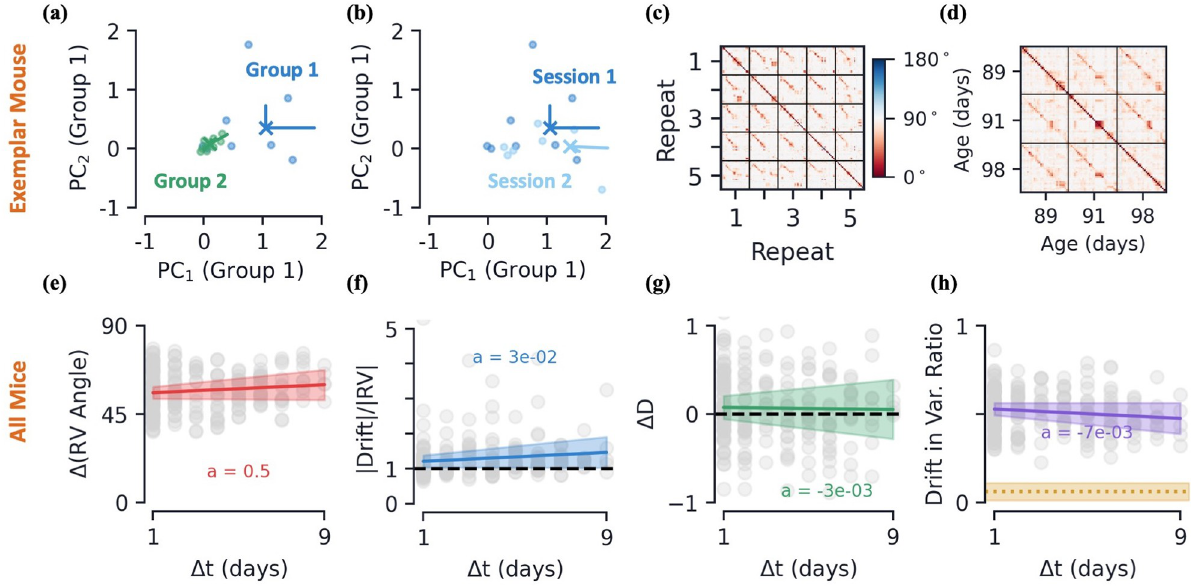
Fig 2. Passive data: Feature space, drift, and drift’s dependence on time. [a-d] Data from an exemplar mouse. (a) Response vectors (dots), mean response vectors (X’s), and first two PC dimensions (lines, scaled by variance explained), for two stimulus groups in a given session. Plotted in stimulus group 1’s PC space. (b) Same as previous subplot, but response vectors of stimulus group 1 across two different sessions, plotted in session 1’s PC space. (c) Pairwise angle between the response vectors of the 30 1-second time-blocks across the first five movie repeats of a single session. (d) Pairwise angle between mean response vectors across the three different sessions, same color scale as (c) (Methods). [e-h] Various metrics as a function of the time between earlier and later session, Δ t , for all mice. All metrics are computed for each individual stimulus group, then averaged across all 30 groups. Colored curves are linear regression fits and shaded regions represent all fits within 95% confidence intervals of slope and intercept. (e) Average angle between mean response vectors. (f) Average (L2) magnitude of drift relative to magnitude of earlier session’s mean response vector. (g) Average change in variational space dimension, D , from later session to earlier session. (h) Average drift magnitude within earlier session’s variational space, ratio relative to full drift magnitude, see Eq (9). In yellow, the same metric if drift were randomly oriented in neural state space (mean ± s.e., across mice).